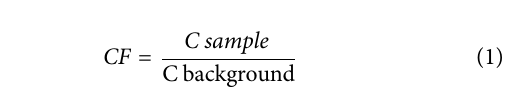
Frontiers in Earth Science |